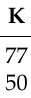
Table 7. Nutrient apparent recovery efficiency of Chinese cabbage plants from OF for N, P and K (%).